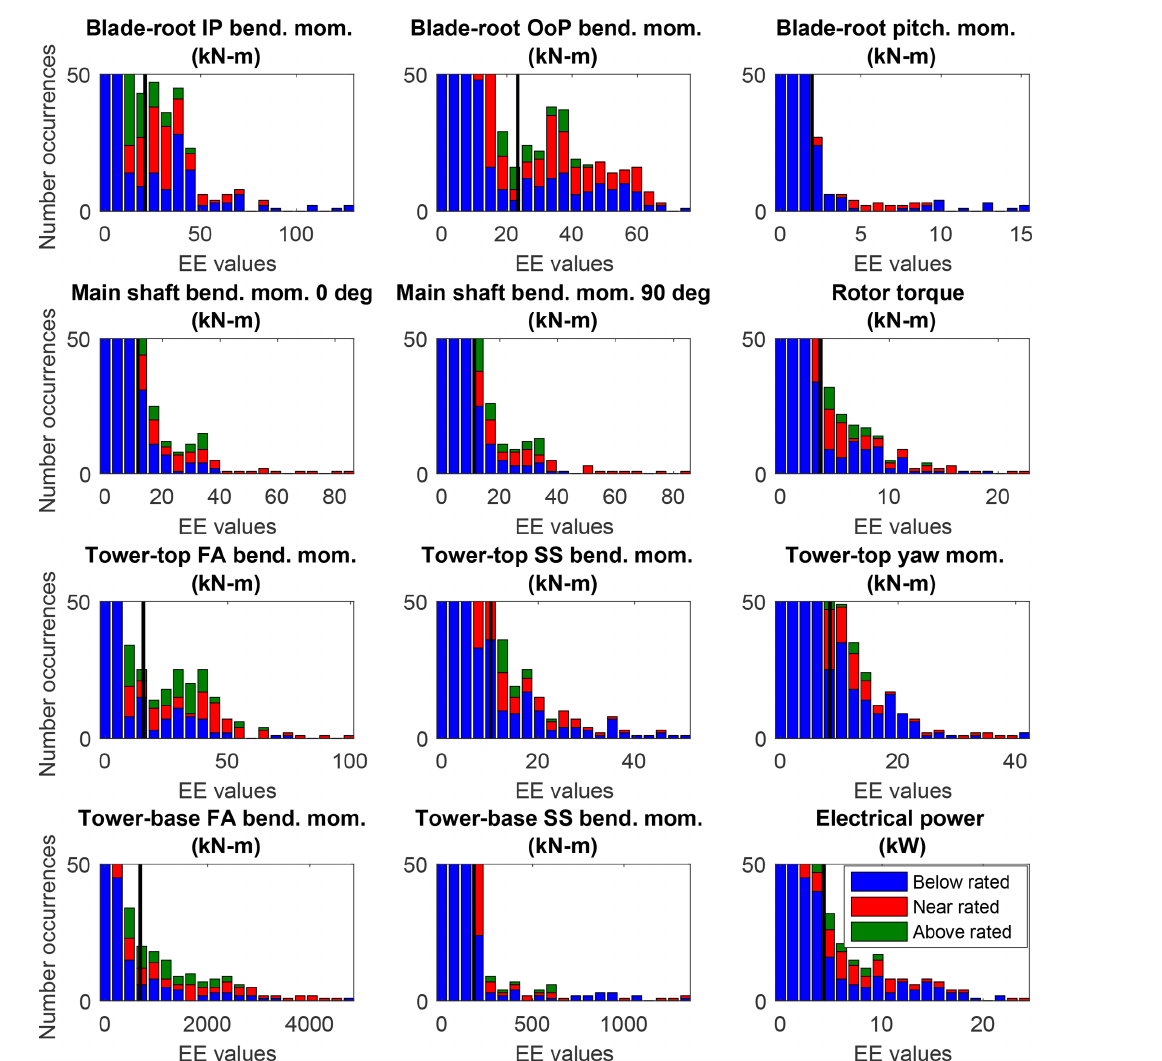
Figure 15. Zoomed-in stacked EE-value histograms of fatigue loads across all wind speed bins, input parameters, and simulation points for all QoIs. The black line represents the threshold by which outliers are counted for each QoI. Color indicates wind speed bin (blue is below-rated speed, red is near-rated speed, green is above-rated speed).